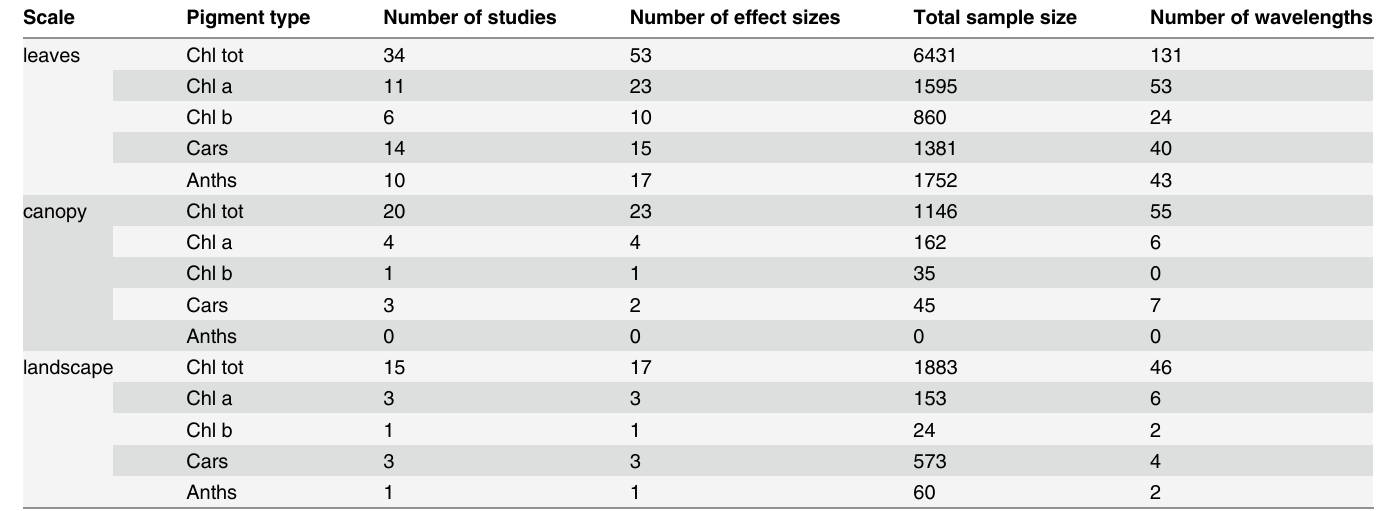
Table 2. Summary statistics for the selected studies and extracted data for different pigment types at leaf, canopy and landscape scales. Scale Pigment